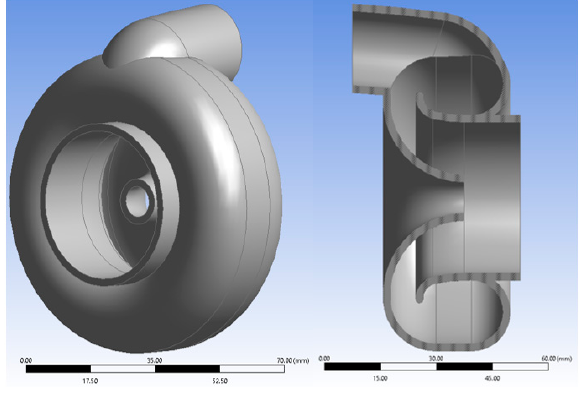
Figure 8. Third volute design.